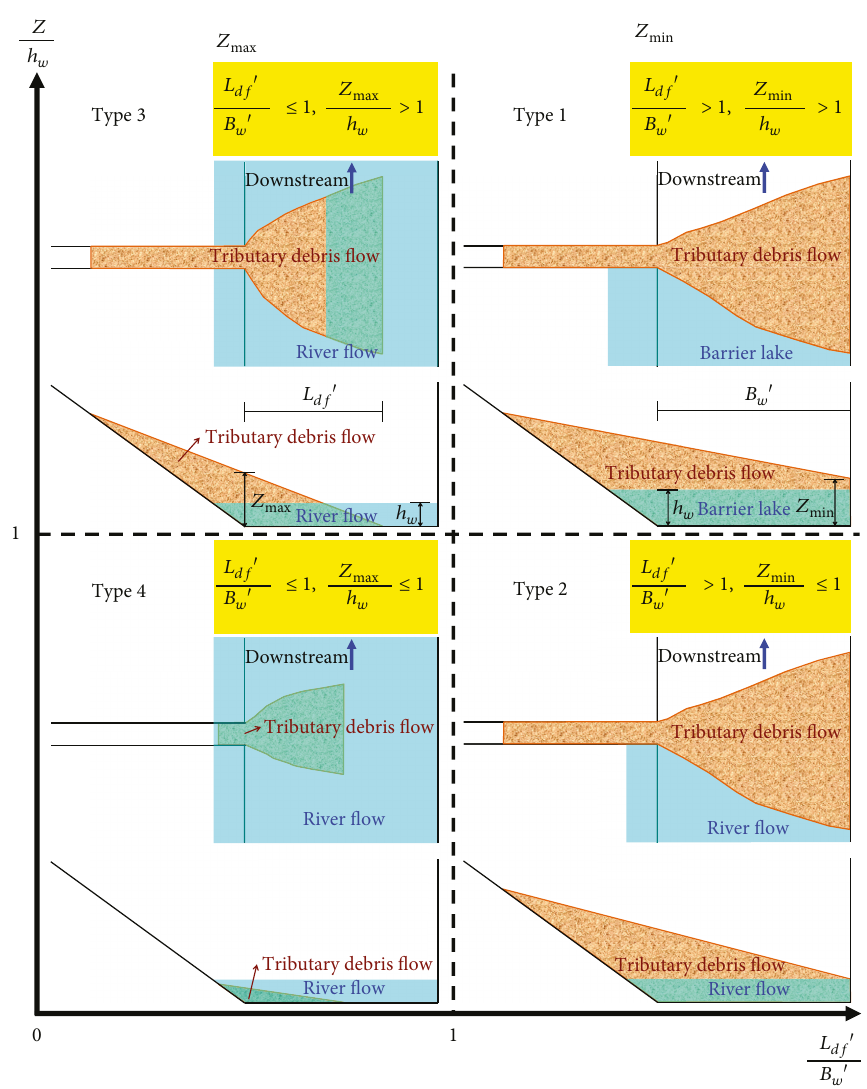
′ is the revised run-out distance of the tributary debris fl ow; df